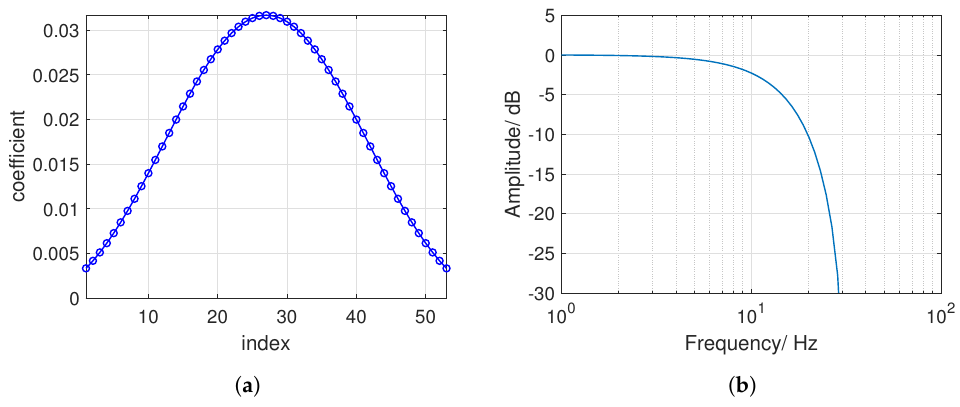
Figure 5. ( a ) FIR filter coefficients and ( b ) frequency response of the FIR